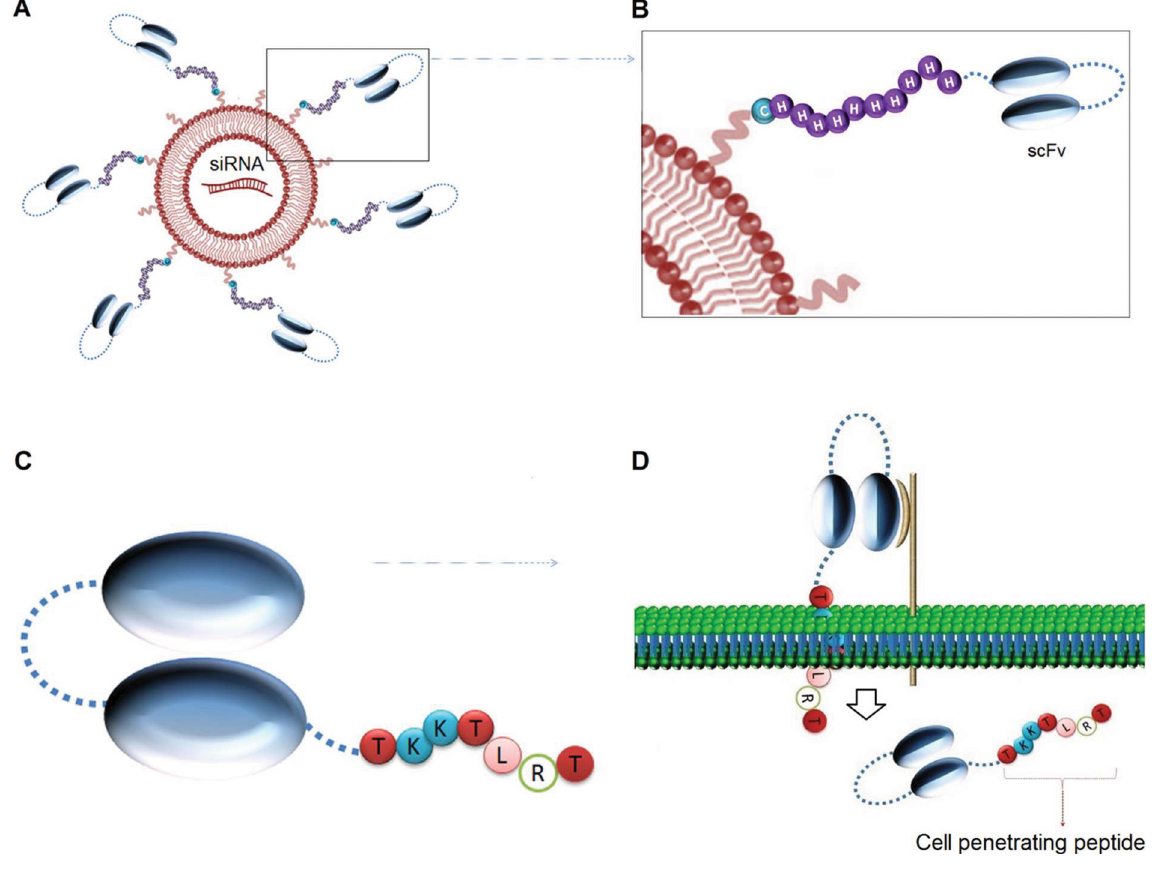
Figure 2. Schematic view of a siRNA-loaded immunoliposome (IL) and a short peptide–scFv fusion peptide. (A) scFv molecules bind to PEG particles on the surface of siRNA-loaded IL to form a targeted siRNA carrier. (B) Targeting ligand of the IL consists of a scFv mol- ecule, a short linker, 10 histidine residues and a cysteine residue that involves in covalently binding to PEG particles. (C) Amino acid sequence of TKKTLRT forms a short peptide with cell penetration capacity. (D) This short peptide allows the fusion peptide to enter the target cells previously recognized by scFv